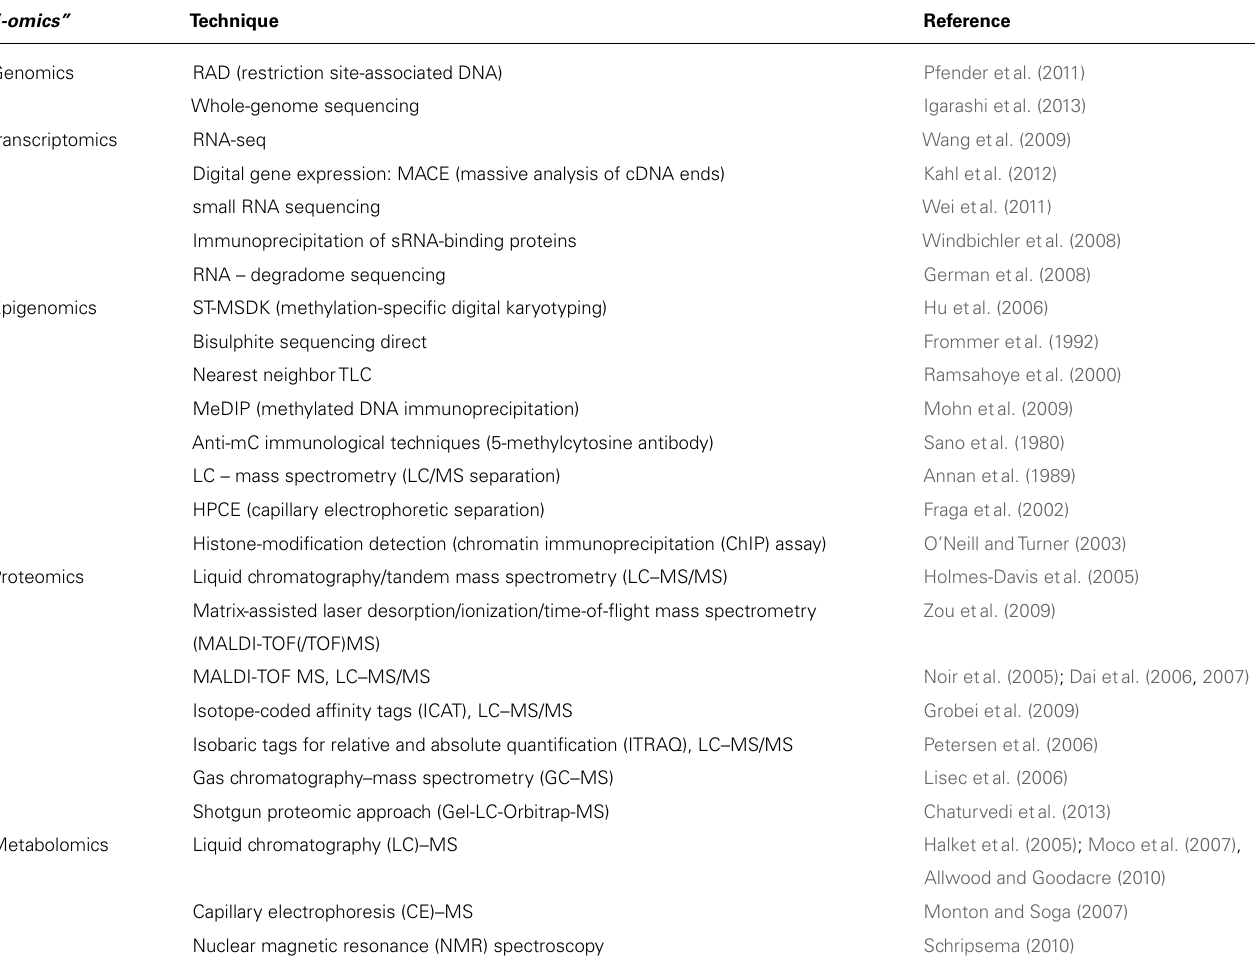
Table 1 | Examples of “ -omics” techniques for the investigation of plant HSR.